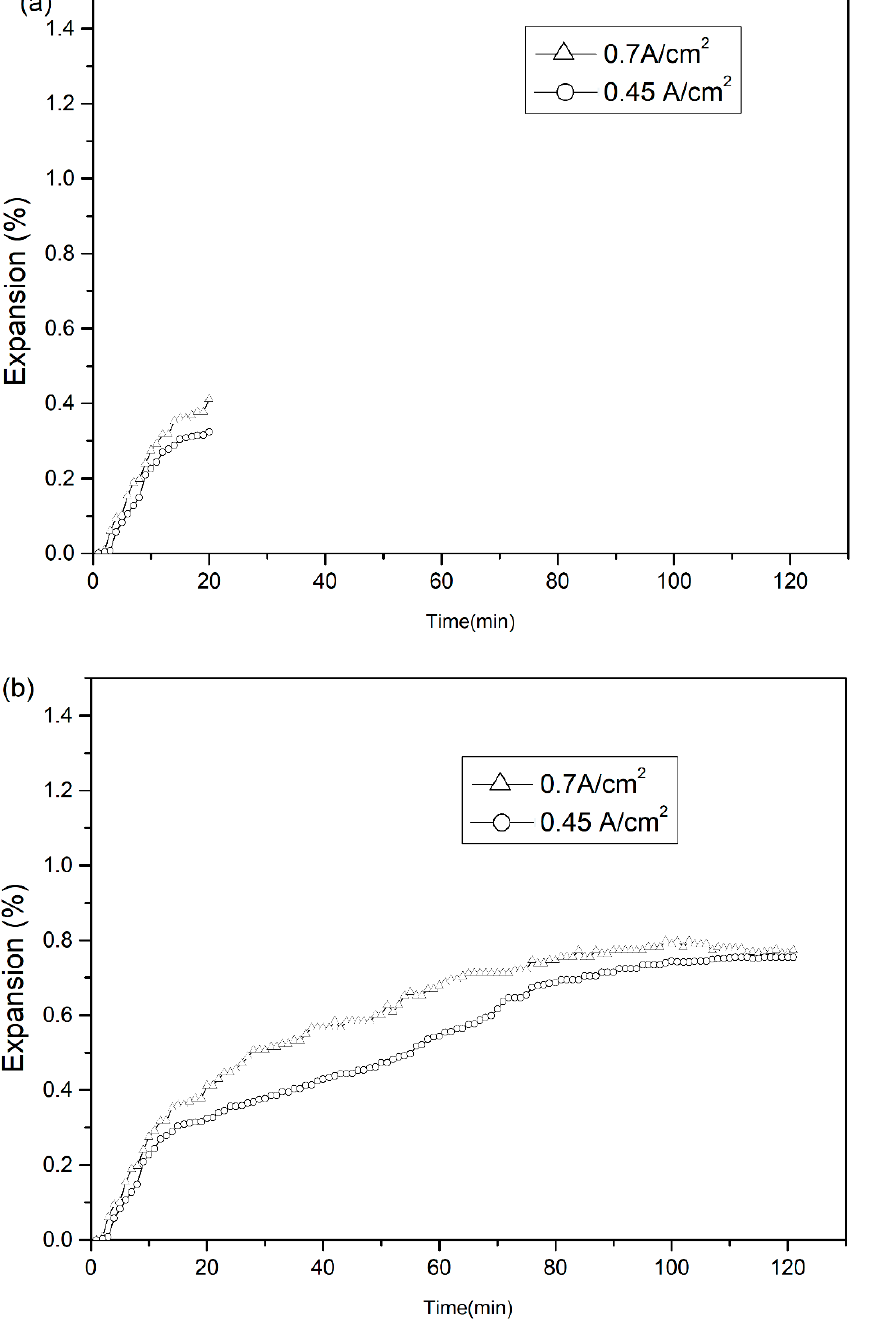
Figure 2. Sodium expansion of the semigraphtic cathode sample at the two values of current density with various testing times (a) 20 min (b) 120 min.